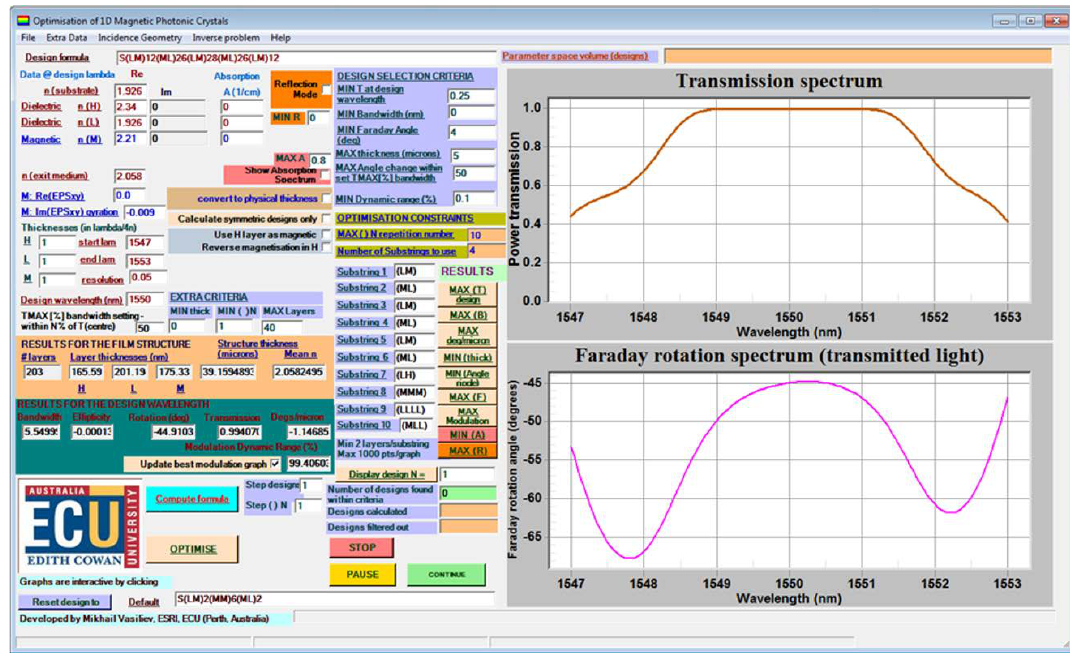
Figure 3. MPC optimization software used to reproduce the flat-top MPC transmission and Faraday rotation spectral properties for a four-defect design reported in [11]. The calculated graphs (obtained after entering the design data and pressing the "compute formula” button) reproduce the data originally presented graphically in Figure 3b of